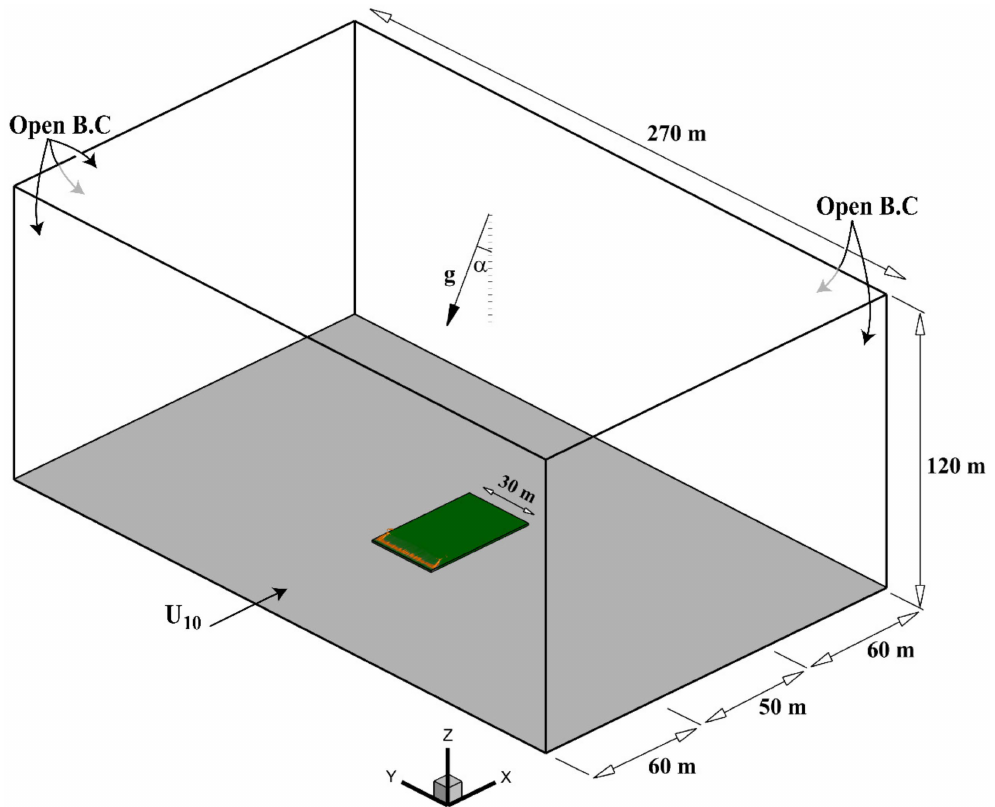
Figure 4. Perspective view showing the dimensions of the computational domain, the boundary conditions and the vegetation